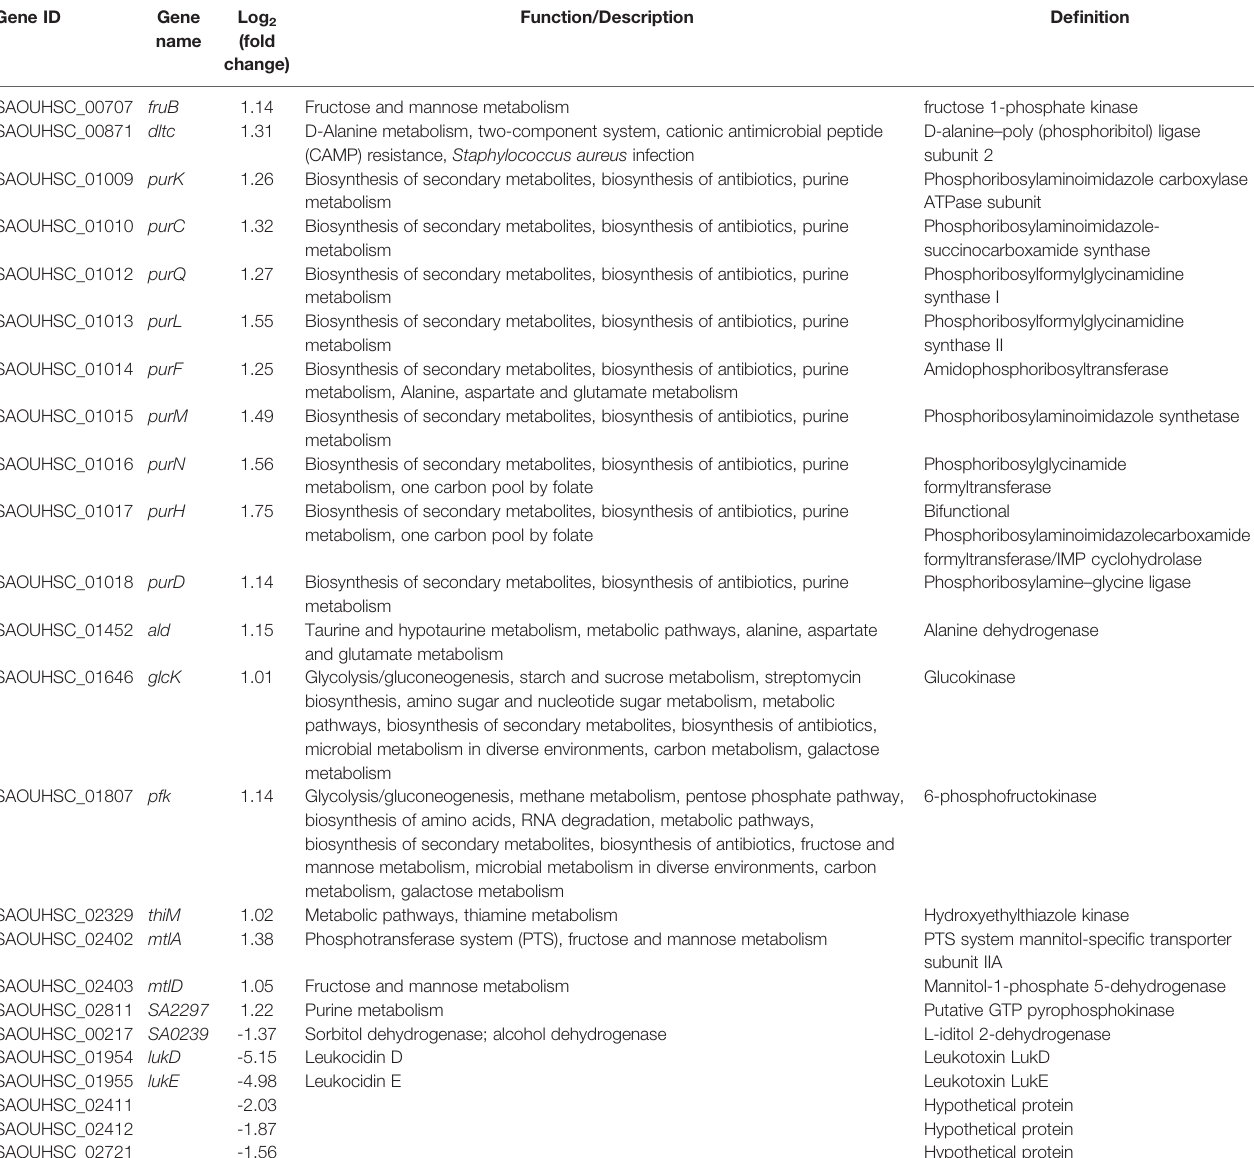
TABLE 2 | The representatives of the signi fi cant differentially expression genes (DEGs) concerning metabolism and virulence in S. aureus sprC mutant compared with wild-type